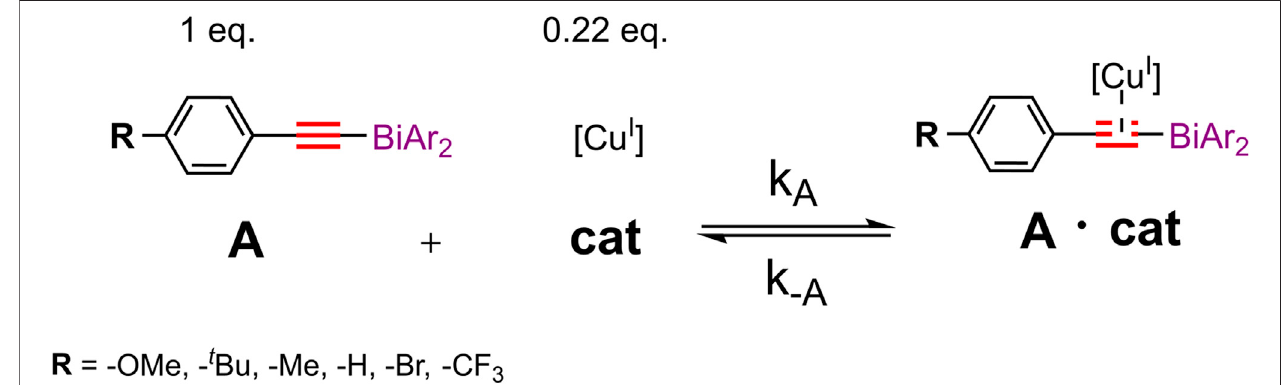
Frontiers in Chemistry |